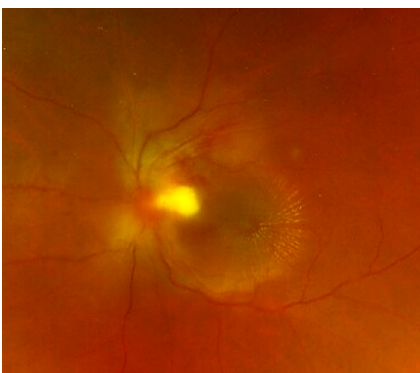
Figure 3: Optic disc swelling, a focal retinitis lesion at the temporal margin of the optic disc, macular exudates in a star pattern, and a flame-like retinal haemorrhage